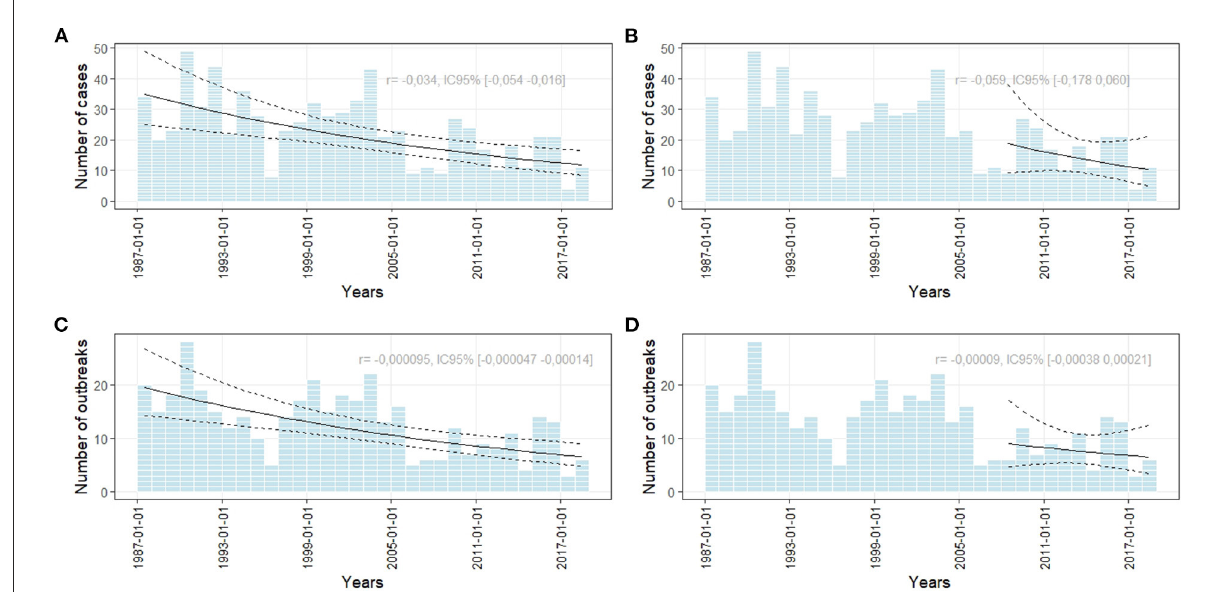
FIGURE1 Number of foodborne human botulism outbreaks and cases based on NRC data. The curves represent a trend analysis over the period 1987–2018 (A,C) and over the period 2008–2018 [panel (B,D) ]. r represents the growth rate of the log-linear model used for assessing the growth or decline of the number of cases or oubreaks.